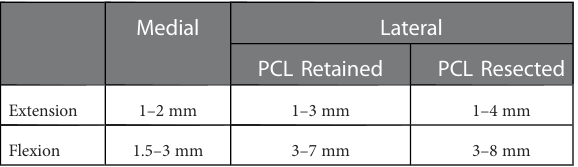
TABLE 1 Flexion and extension gaps in the rKA